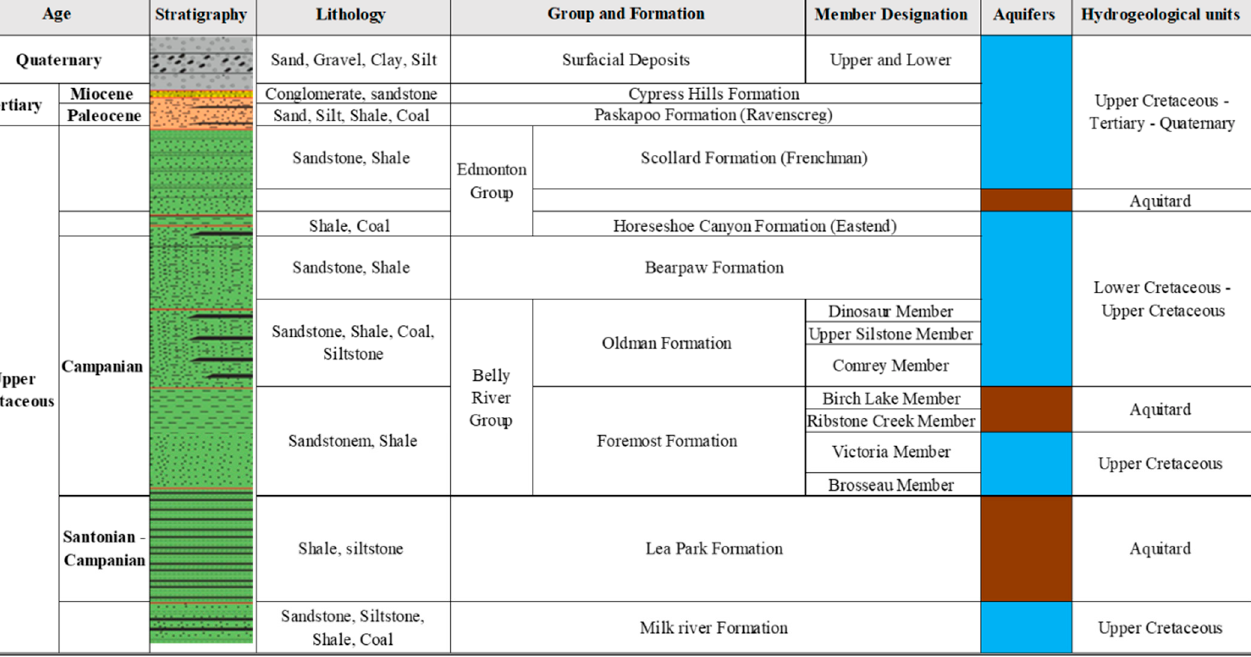
Figure 2. Stratigraphic column of the Saskatchewan River